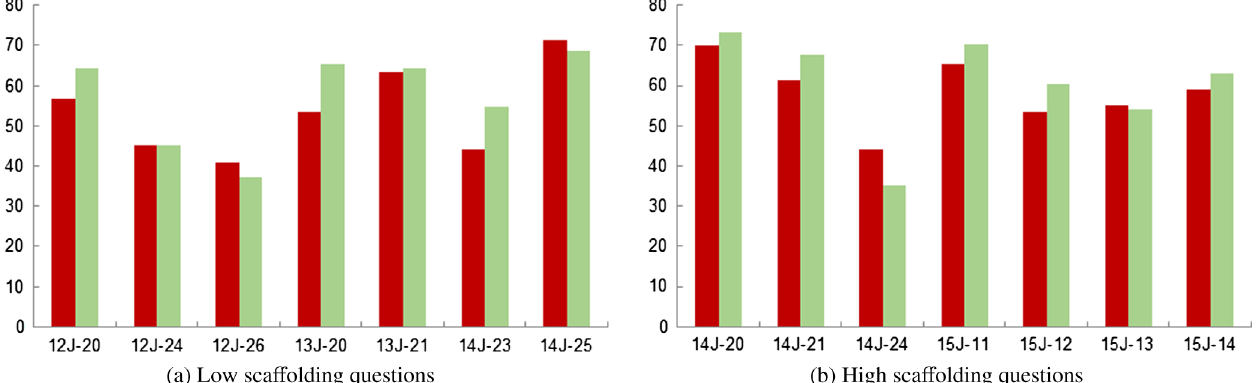
FIG. 3. Average performance (percentage score) of female (red) and male (green) students on all exam questions belonging to the low (a) and high (b) scaffolding groups. Exam questions are labeled as they appear in the Supplemental Material [29].